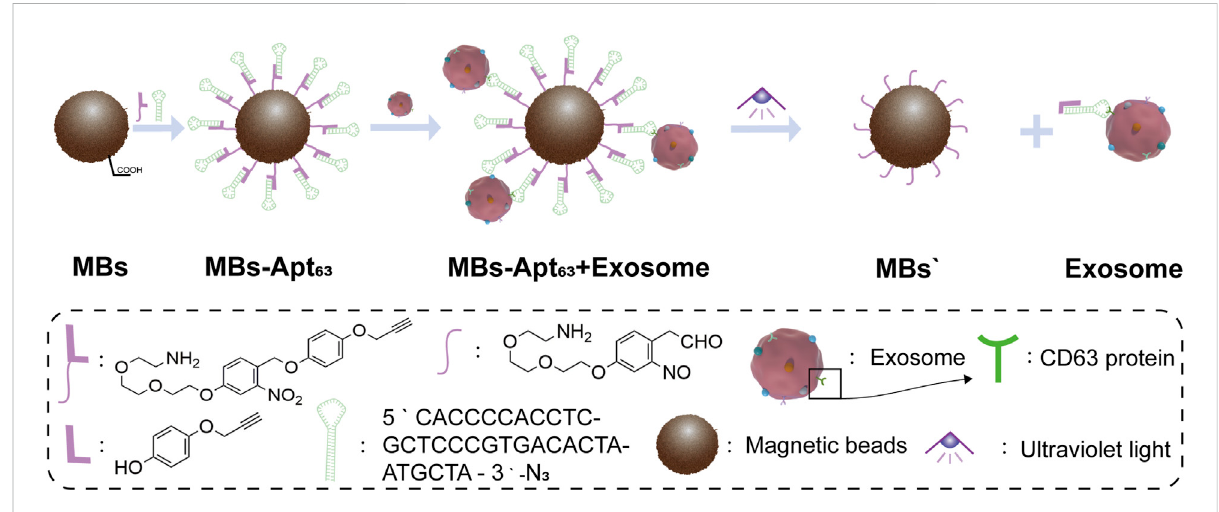
FIGURE 1 Schematic illustration of our ultraviolet-responsive nanomagnetic beads for binding and separation of